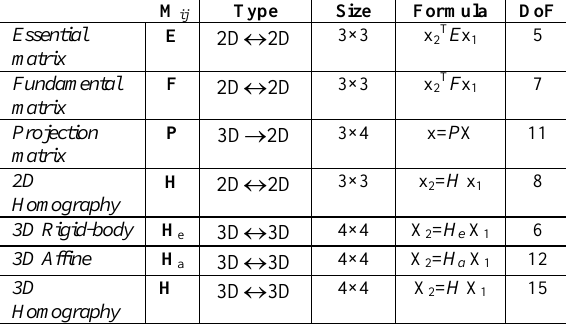
Table 3. Geometric models that can be included in the generalized model for outlier